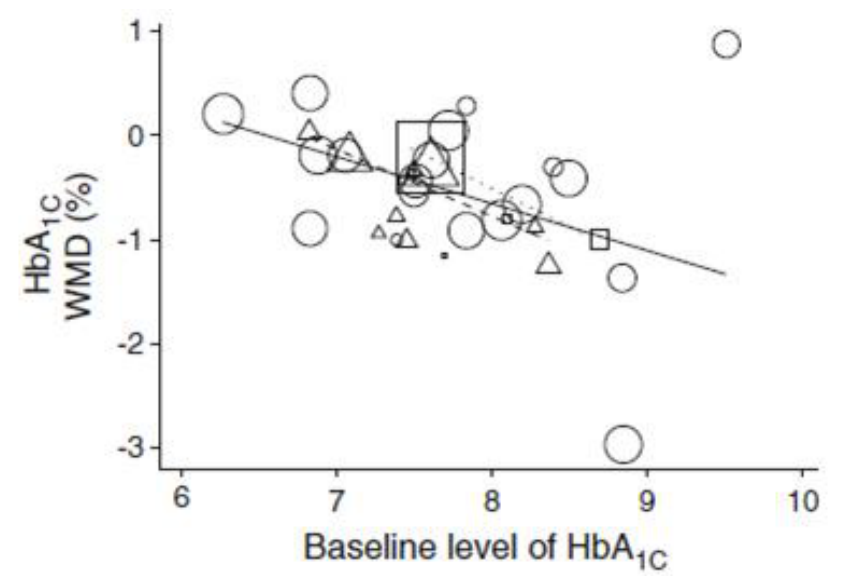
Figure F10-10. Association between HbA1C Before a Supervised Exercise Intervention, with Change in HbA1C After Different Types of Exercise Interventions